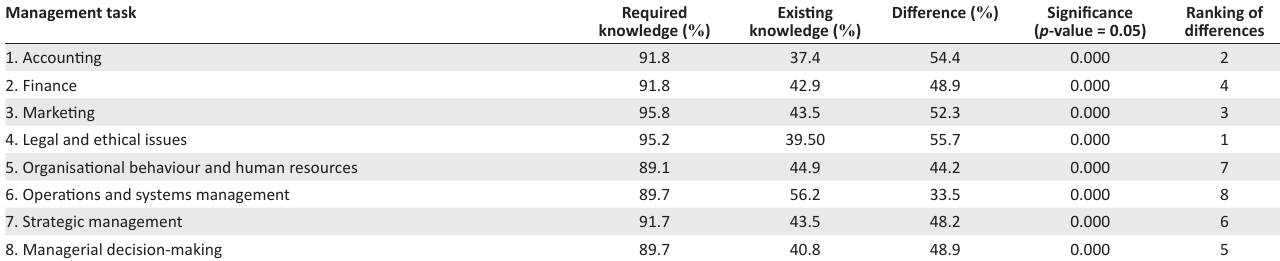
TABLE 4: Difference between respondents’ existing levels of knowledge and required knowledge necessary to perform practice management tasks ( n = 147). Management task